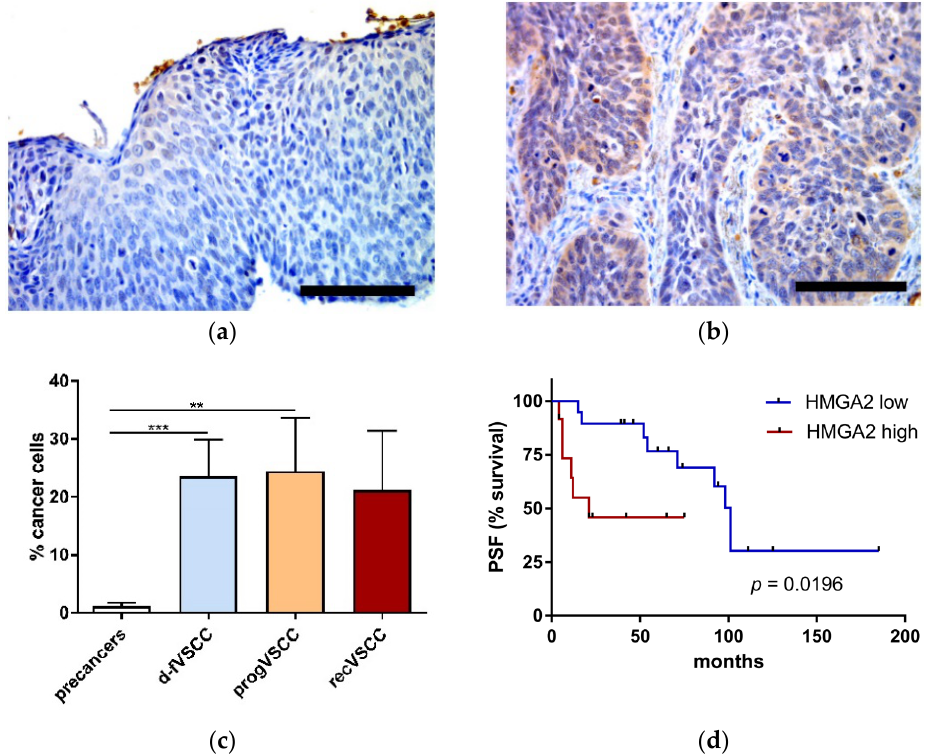
Figure 2. The percentage of HMGA2-positive neoplastic cells. Examples of immunohistochemical HMGA2 staining performed on tissue sections of high-grade squamous intraepithelial lesions (HSIL) ( a ) and progVSCC ( b ) tumor samples. Images were taken at 40× magnification. Scale bar, 100 µ m. Comparison of the IHC results for premalignant lesions (HSIL; n = 44 and dVIN; n = 6), d-fVSCC ( n = 19), progVSCC ( n = 13) and recVSCC ( n = 7) samples ( c ). Survival curve (time to progression) according to the relative numbers of HMGA2-positive cancer cells in primary VSCC tumors ( n = 31) ( d ). Significant alternations are indicated by asterisks (**, p -value ≤ 0.01; ***, p -value ≤ 0.001). Abbreviations: PFS, progression-free survival; high and low, high and low proportion of HMGA2-positive cancer cells ( ≥ 30 and ≤ 10 cells, respectively).